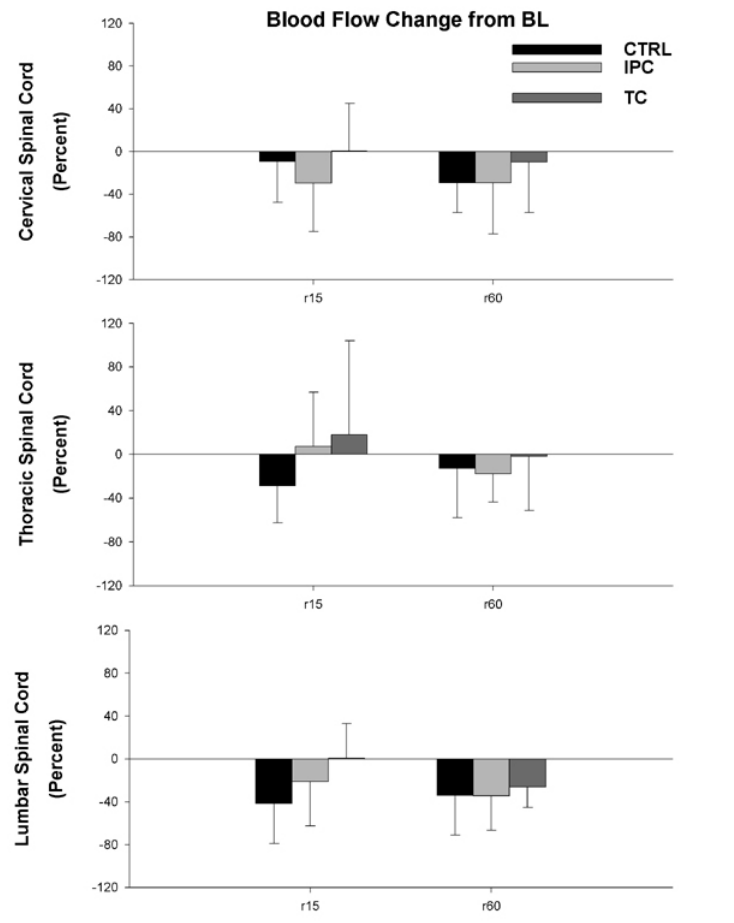
FIGURE 2 . Change in microsphere calculated blood flow compared to baseline in control (CTRL), ischemic preconditioned (IPC), and time control animals (TC). r15 = 15 min into reperfusion; r60 = 60 min into